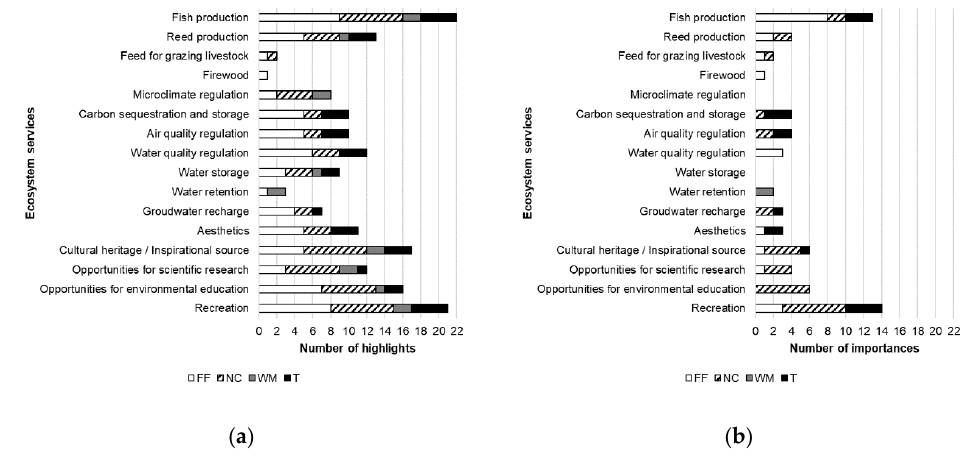
Figure 2. Knowledge and perceptions of key-informants: ( a ) The number of times when an ecosystem service (ES) was highlighted by the members of each stakeholder sector, where FF—fish